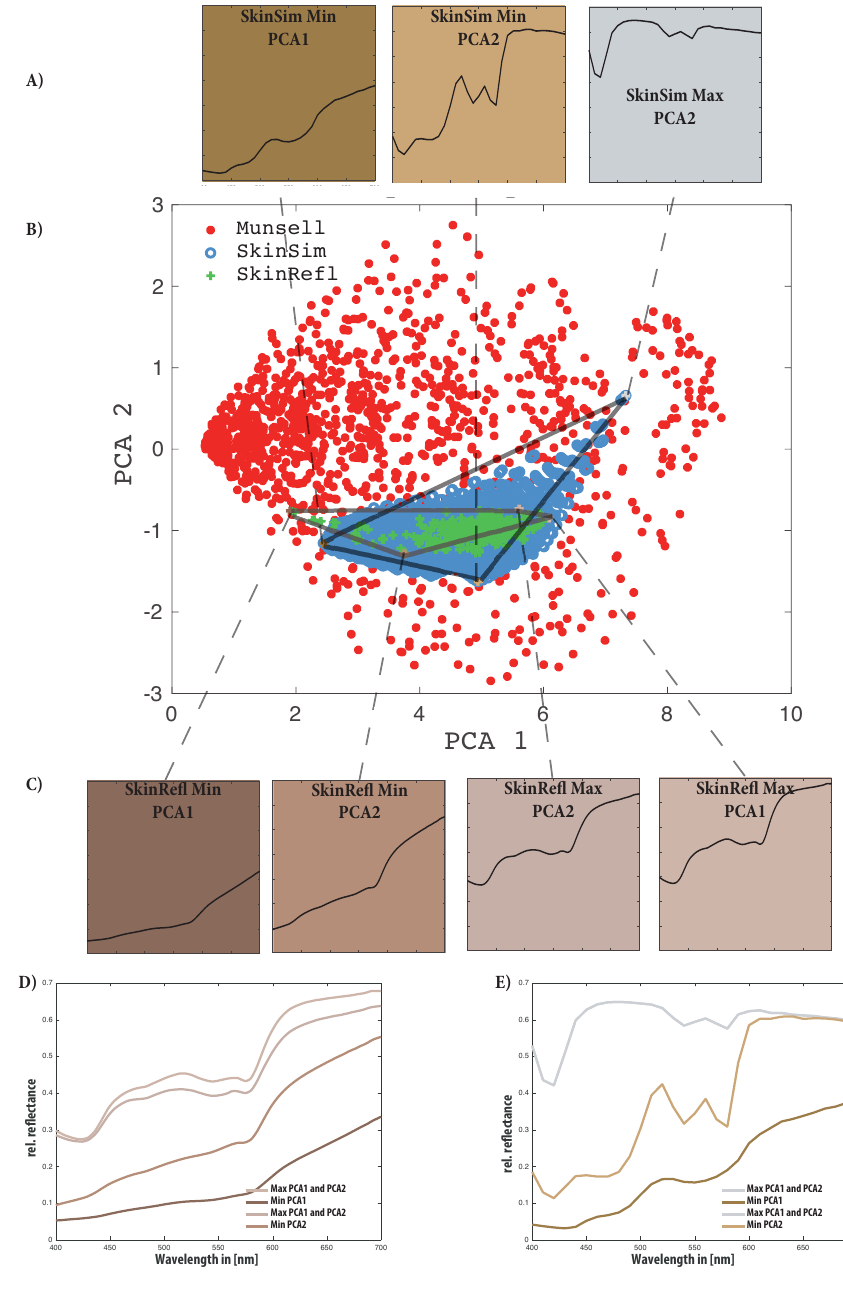
Figure 5. Dimensionality analysis of all sets combined ( B ) skin simulation (blue), skin reflectance (green) and Munsell reflectances (red). Colored markings for maximum PCA1, minimum PCA1, maximum PCA2, minimum PCA2, for skin simulation and skin reflectance, respectively. Color patch recreation (under D65 light source) of the extreme spectra for the skin simulation ( A ) and skin reflectance database ( C ) with minimum PCA 1 and PCA 2 and maximum PCA 1 and PCA 2. Plot of the maximum and minimum spectra for the skin reflectance database ( D ) and skin simulation database ( E ) according to PCA